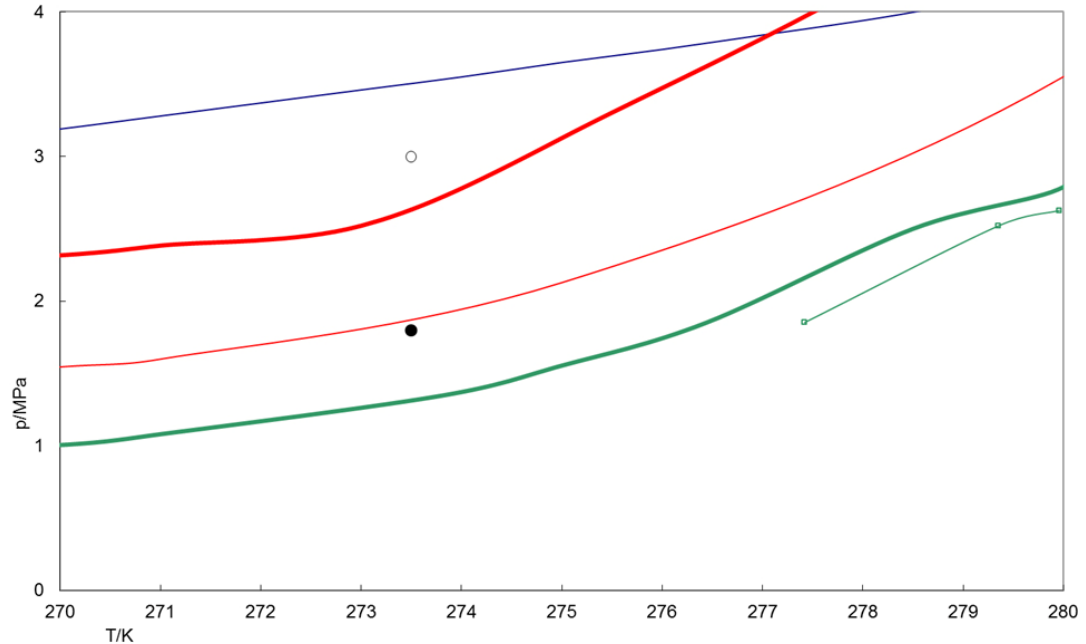
Figure 5. Stability fields of simple CO hydrates (bold green line), mixed CO 2 (fine green line) formed from CO (99%)-SO (1%) gas mixture, CH 2 2 and CH (93%)-C H (7%) hydrates (fine red line). Also shown are the CO 4 2 6 boundary (blue line) and experimental p-T conditions (dots). Data according CSMHyd [25], data of CO -SO hydrate stability taken from Beeskow-Strauch 2 2